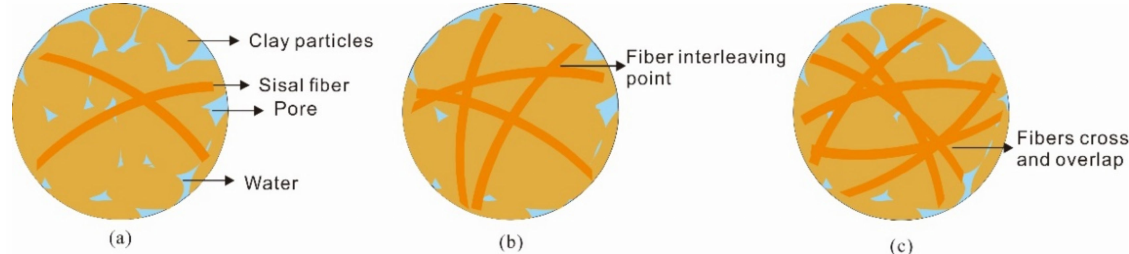
Figure 12. Bottom morphology of fiber-reinforced sample: ( a ) 0.4% fiber content; ( b ) 0.8% fiber content; ( c ) 1.2% fiber content.